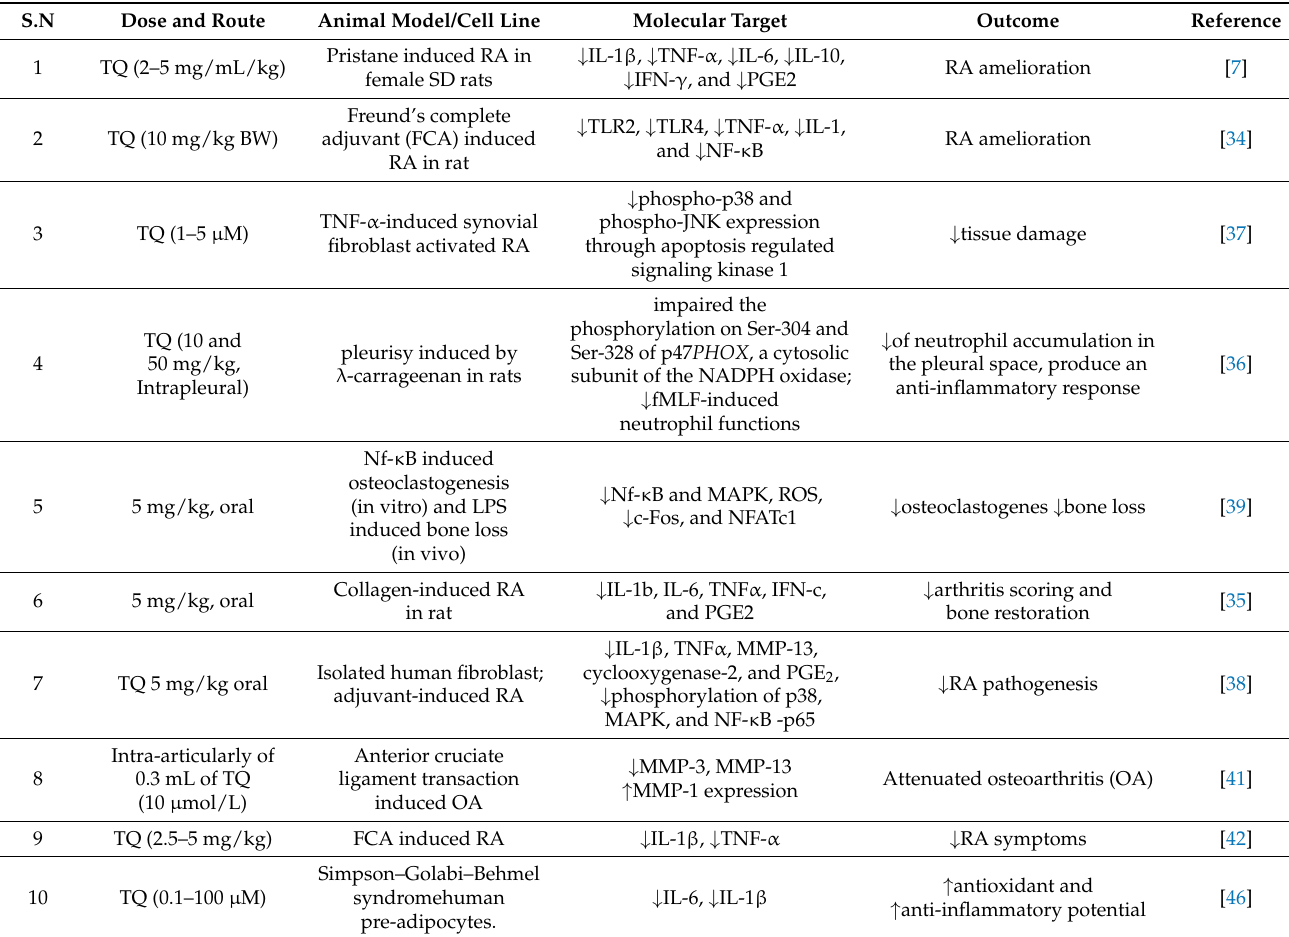
Table 2. Applications of thymoquinone in the treatment of inflammation and arthritis ( ↓ : decrease, ↑ : increase).